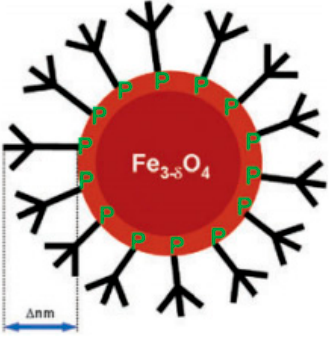
Figure 6. Illustration representing a hydrophilic pegylated dendrons covalently bonded to an iron oxide nanoparticle via a phosphonate anchor. Reproduced with permission from Basly, B.; Felder-Flesch, D.; Perriat, P.; Billotey, C.; Taleb, J.; Pourroy, G.; Bégin-Colin, S. “Dendronized iron oxide nanoparticles as contrast agents for MRI.” Chem. Commun., 46 (2010) 985. Copyright (2010) Royal Society of Chemistry.